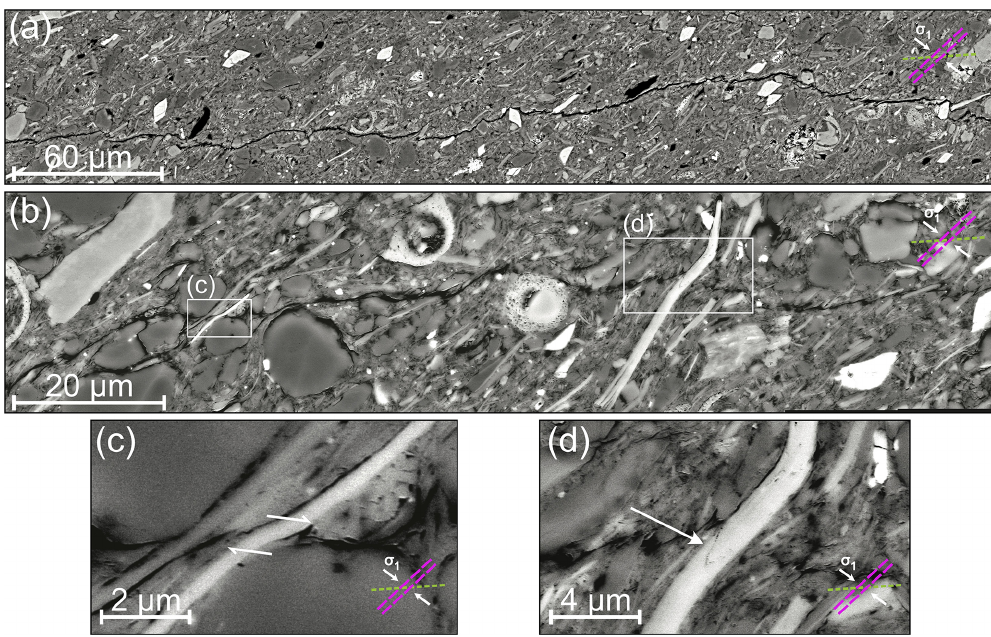
Figure 4. BIB–SEM micrographs (BSE) showing microfractures of variable sizes with apertures of a few micrometres, which cross the bedding obliquely. Fractures formed along larger grains (a) or across elongated mica grains (b) by either creating shear displacements (c) or brittle transgranular fractures (d) . Maximum loading direction, macroscopic fracture set 1 (green), and bedding direction (pink) are indicated for each micrograph in this and all subsequent